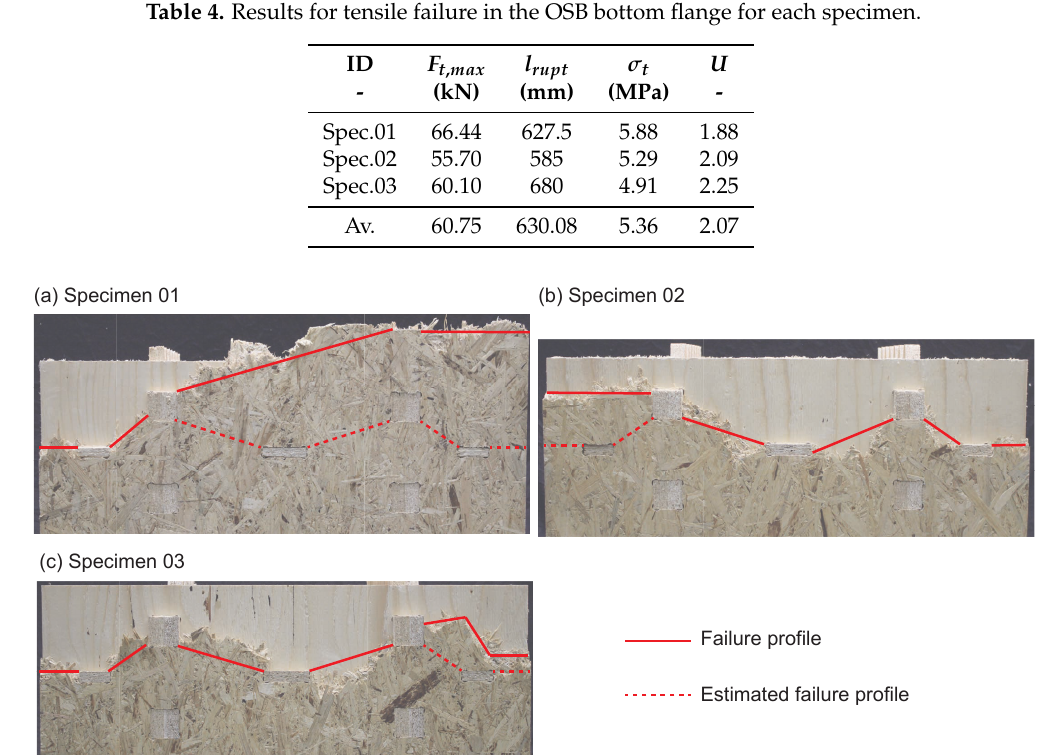
Figure 9. Tensile failure profile of OSB bottom flange